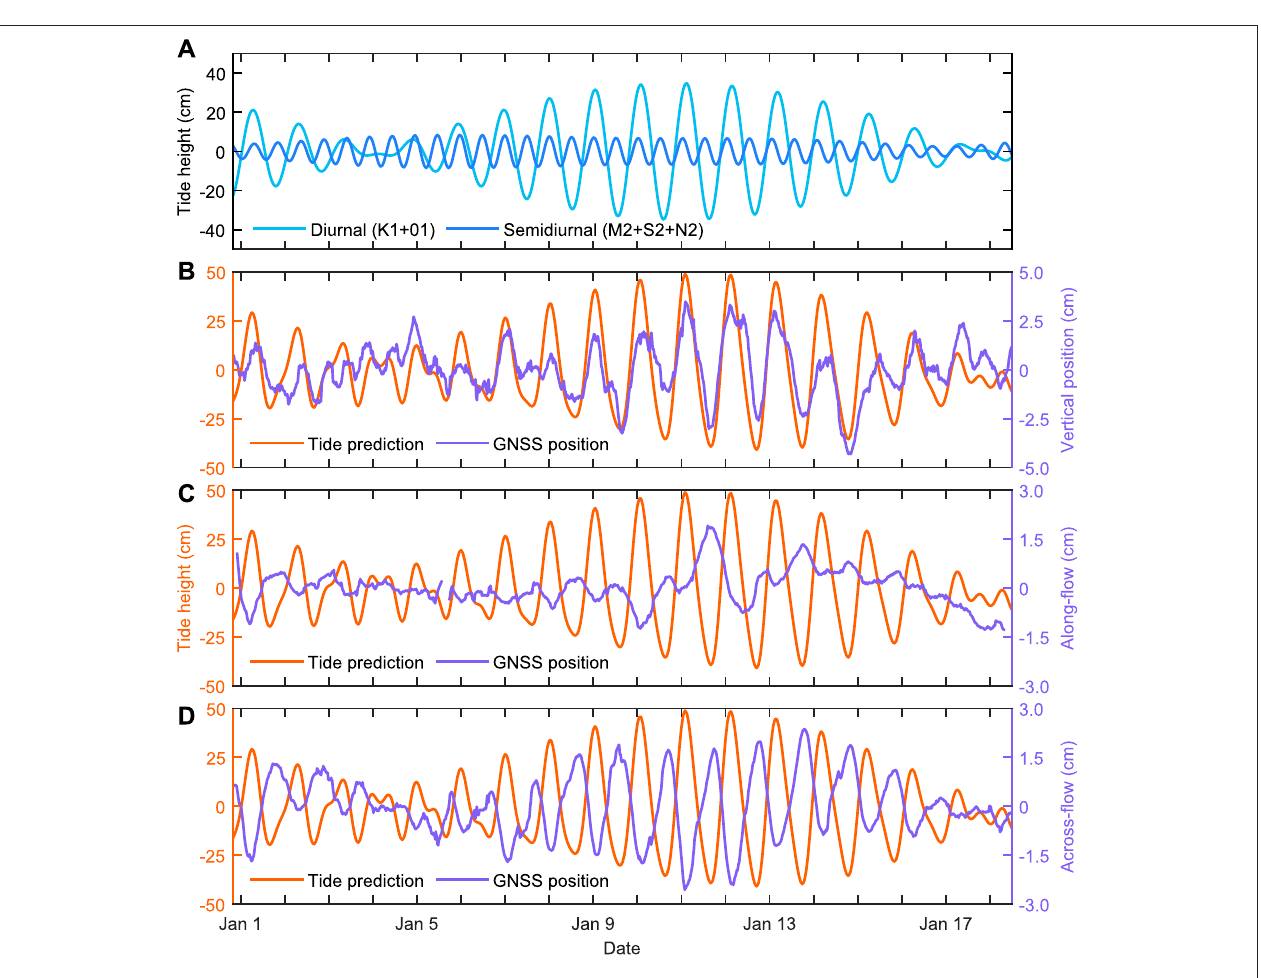
FIGURE3| Panel (A) isthepredicted diurnal andsemidiurnal tidesforPriestley Glacier. Note thattheamplitude ofthesemidiurnal signal exceeds thediurnalsignal during the neaptide (4th and 18thJanuary). (B) isacomparison betweenthe detrended surfaceelevation time series from GNSS positioning and thetideprediction. (C) is the detrended along- fl ow position with the mean displacement rate removed. Positive values indicate an increased rate of displacement in the downstream direction. (D) is the across- fl ow position with negative horizontal displacements indicating ice motion towards the glacier margin. Timestamps are in local time (UTC+13 h).